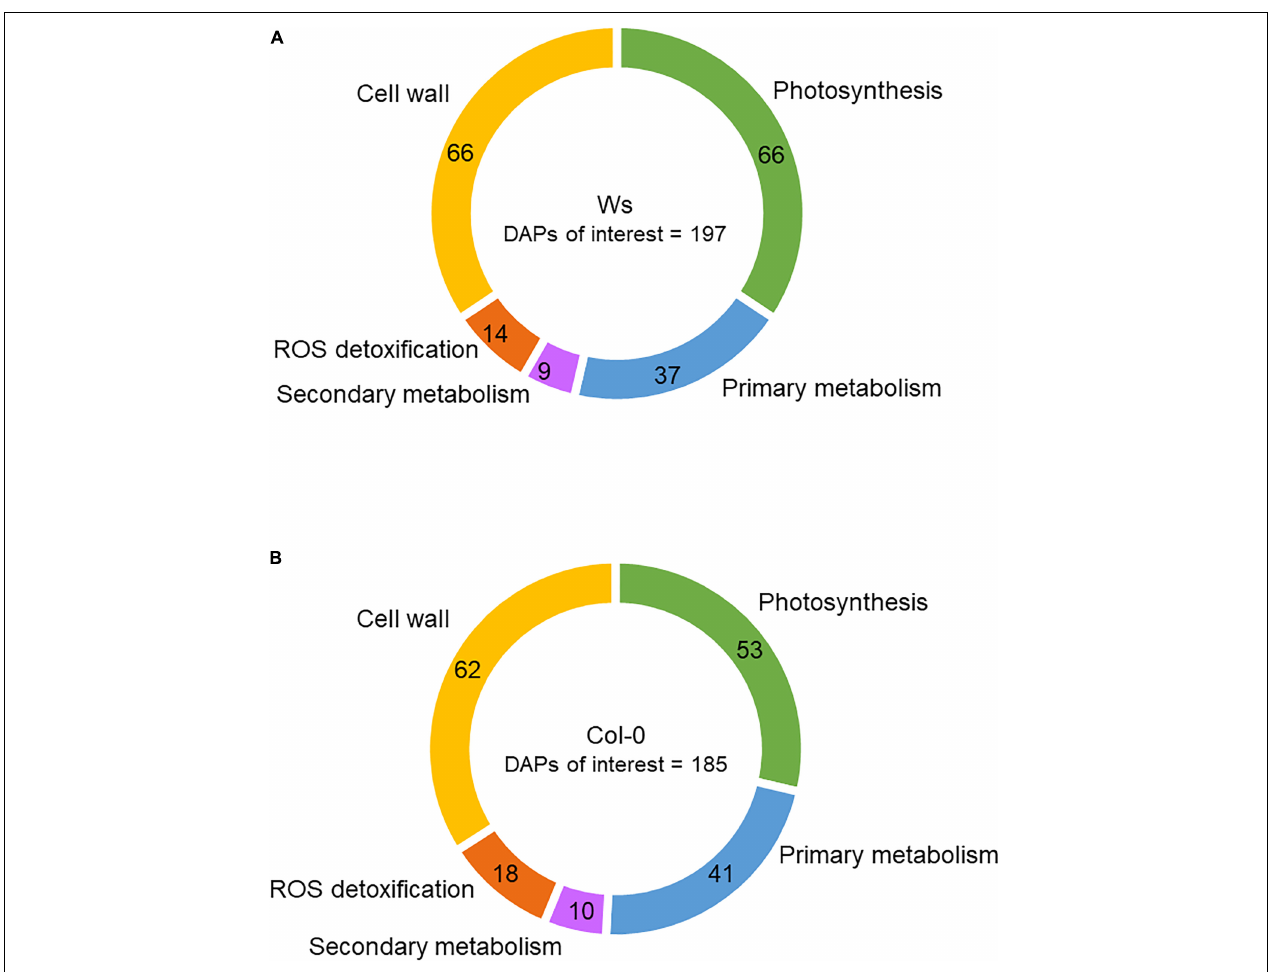
FIGURE 6 | Functional categories of proteins differentially accumulated (DAPs) in the shoots of Ws (A) and Col-0 (B) . The numbers correspond to the distribution of DAPs among the different functional categories.